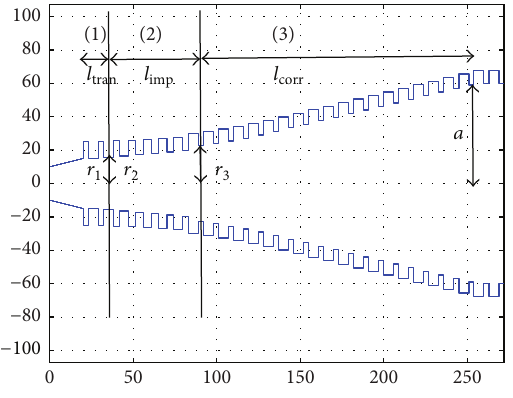
Figure 1: Corrugated horn antenna